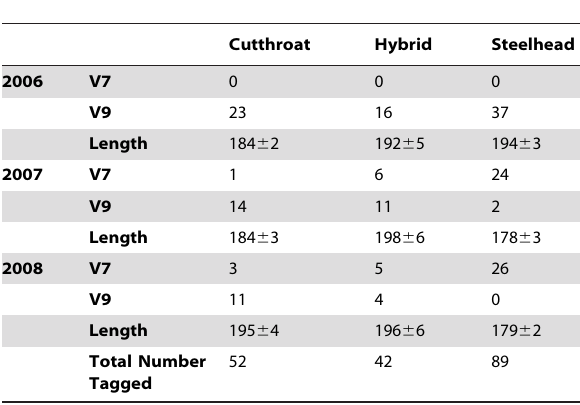
Table 1. Tag type and length summary by